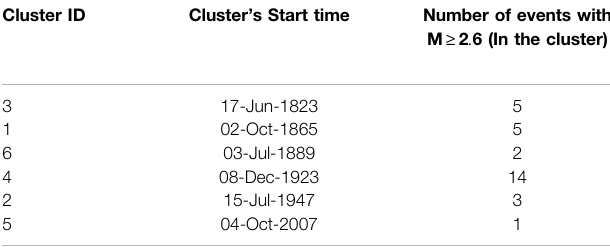
TABLE 2| Selectedstarttime ofthe6clustersidenti fi edusingtheclusteranalysis. Cluster ID Cluster ’ s Start